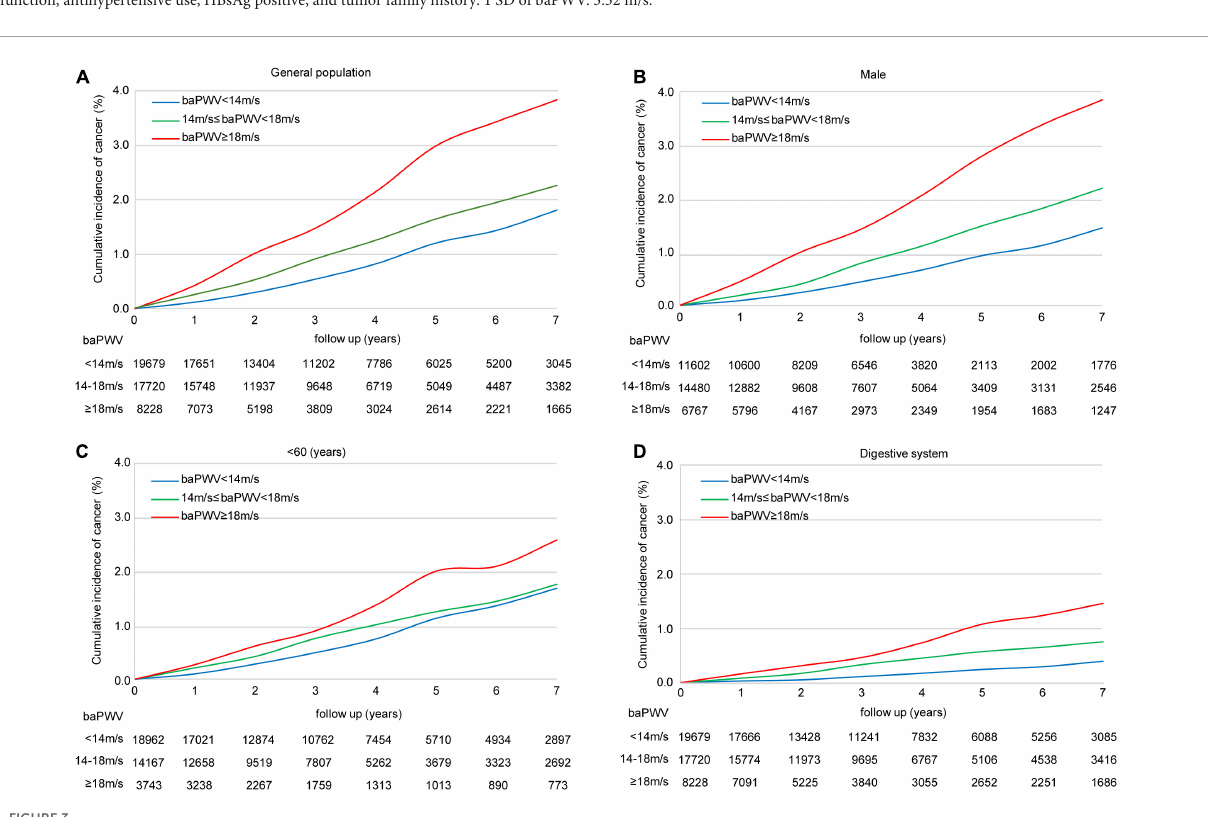
analyses showed a linearly increasing risk, linking the severity of arterial stiffness to overall cancer risk in the entire cohort ( P = 0.0104), men ( P = 0.0102), and participants < 60 years old ( P = 0.0010). There is also a significant relationship